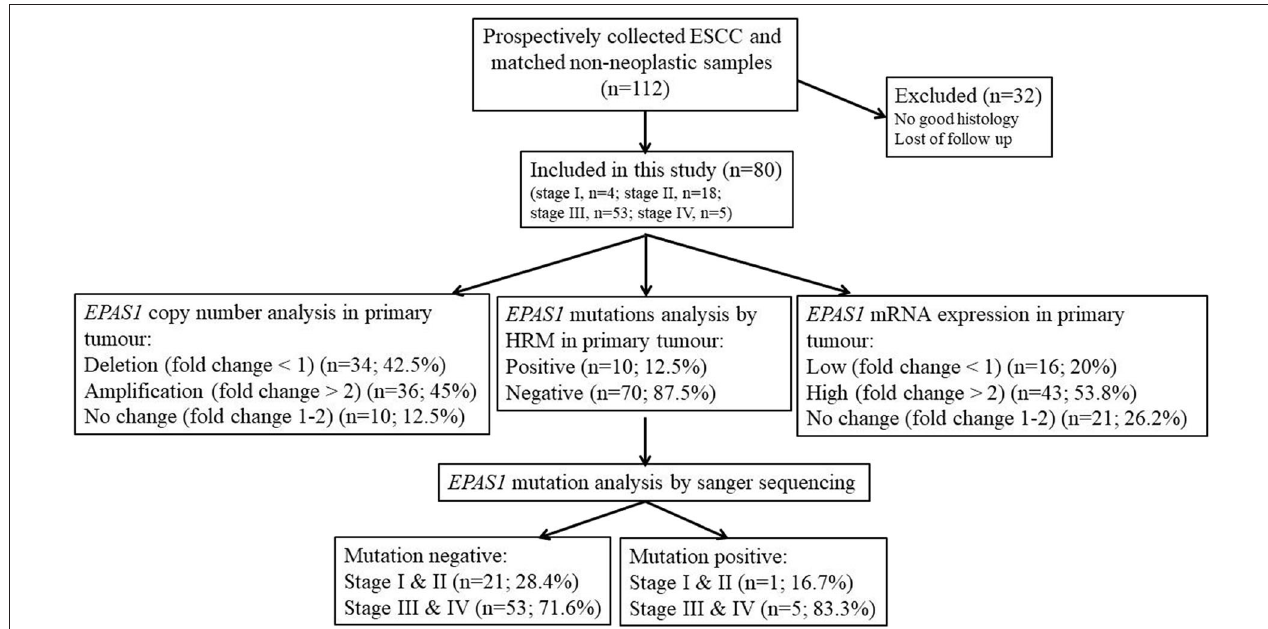
FIGURE 1 | Schematic representation of the methodological flow used for clinical samples analysis in the present study. Tissue samples with poor histology and loss of follow-up were excluded in the present study. Among the samples, 45% showed EPAS1 DNA amplification, whereas 42.5% showed EPAS1 DNA deletion. The rest of the samples (12.5%) showed no changes in EPAS1 DNA. In addition, 53.8% of samples showed high EPAS1 mRNA expression, and 16.2% of samples showed low EPAS1 mRNA expression, whereas 20% of samples did not show any changes in EPAS1 mRNA expression. Furthermore, 12.5% of samples showed EPAS1 mutations, and 87.5% of samples were mutation negative in the present